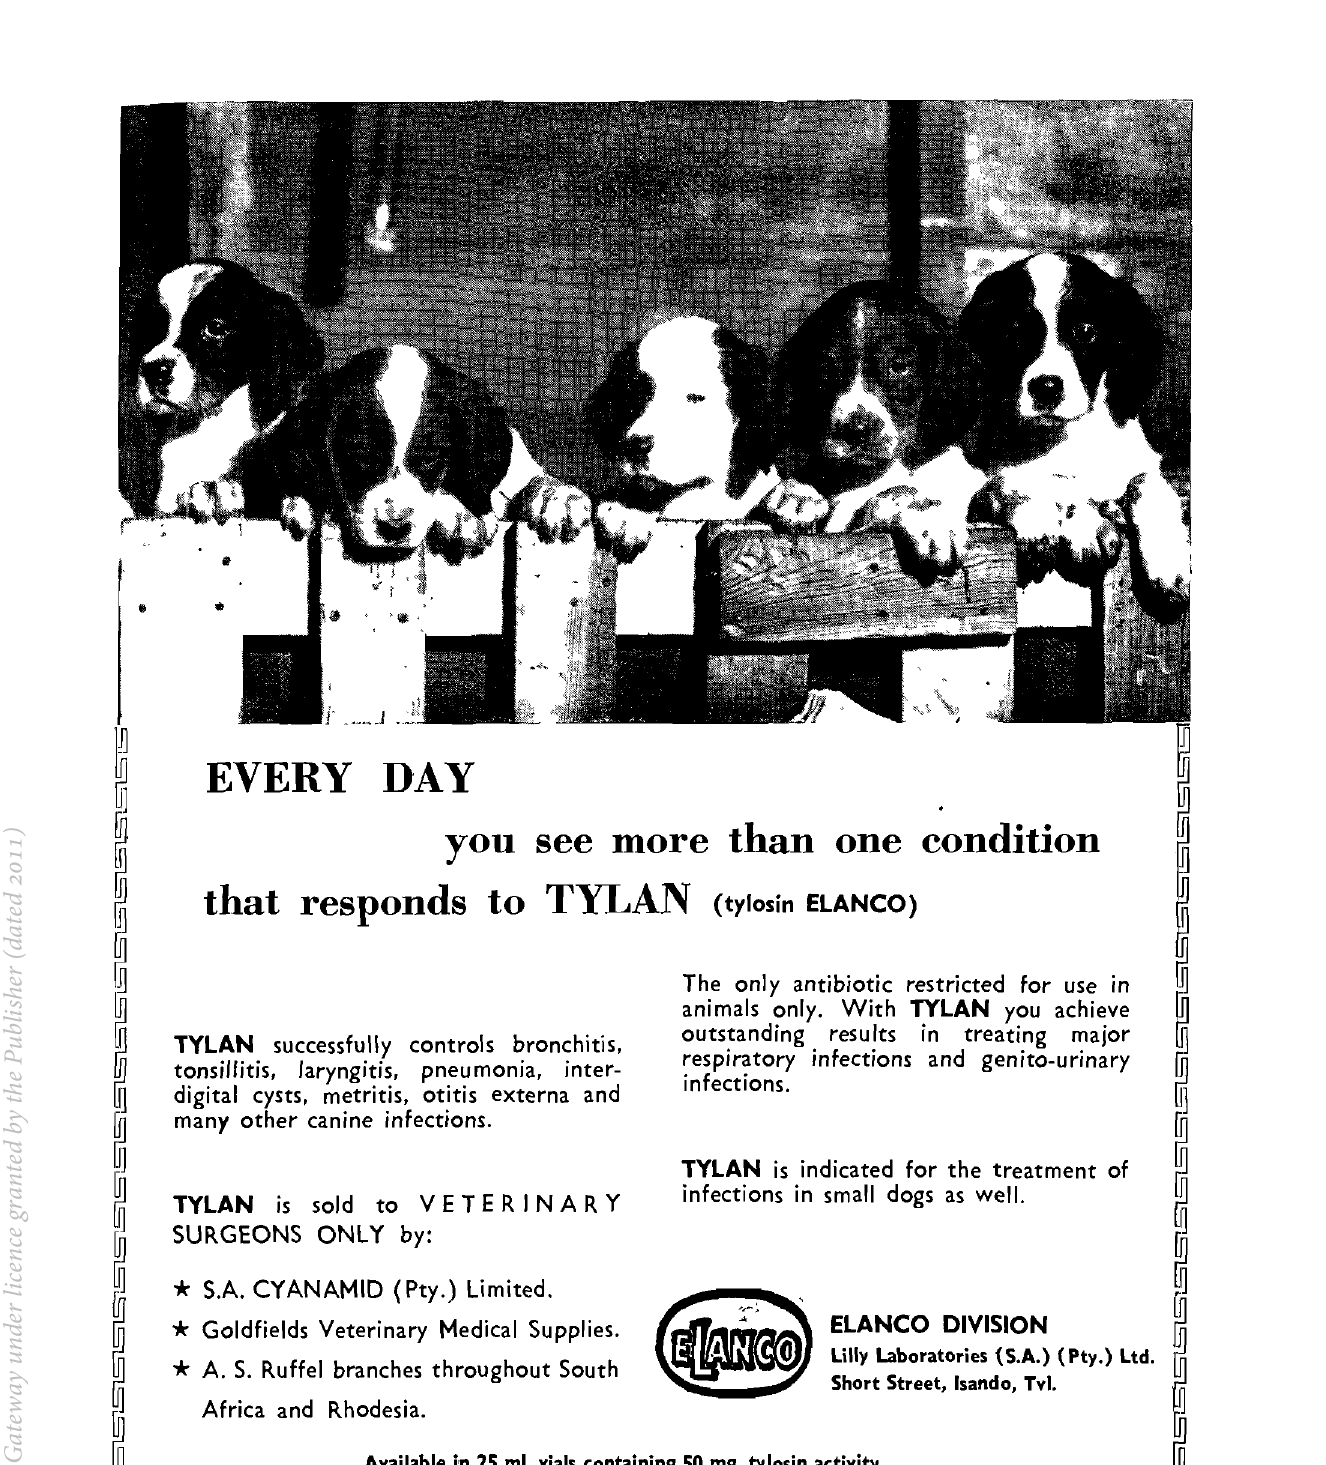
~ ELANCO DIVISION Short Street, Isando,